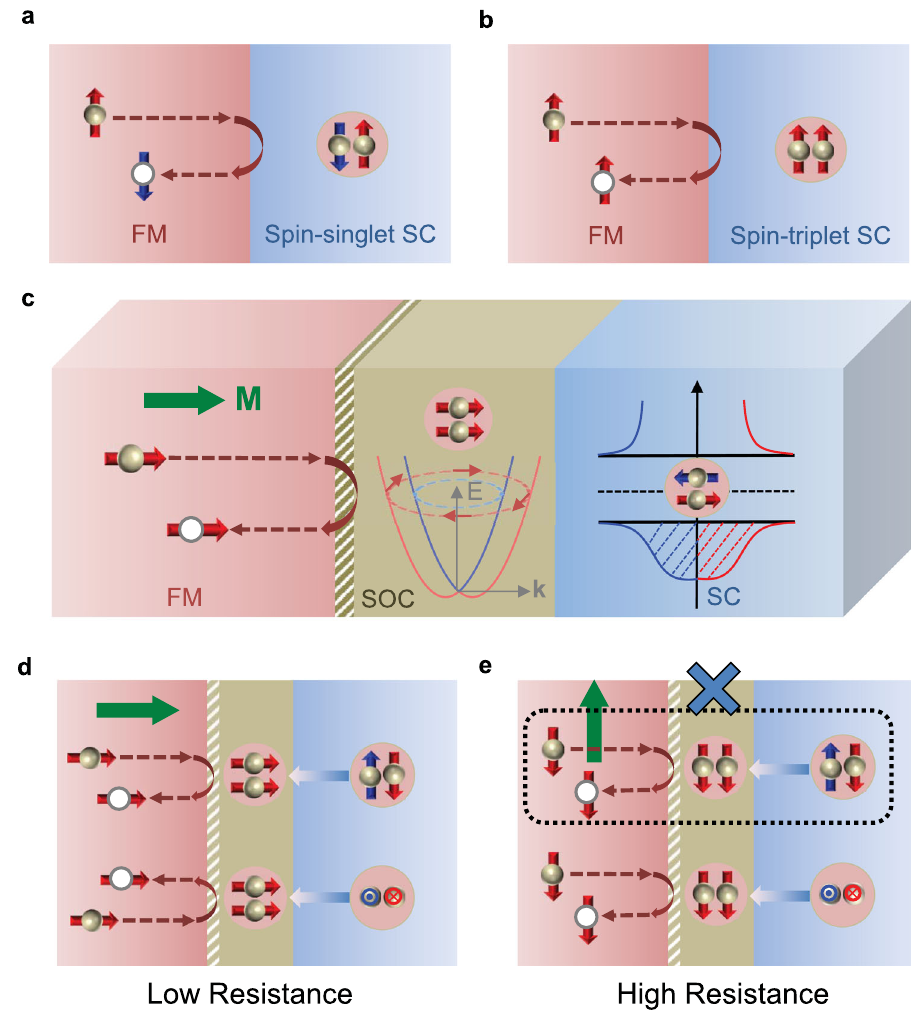
Fig. 1 Schematic of the spin-triplet Andreev re fl ection at FM/SC interface. a Conventional Andreev re fl ection at the FM/spin-singlet SC interface. b The spin-triplet Andreev re fl ection at the FM/spin-triplet SC interface. c Schematic of the spin-triplet Andreev re fl ection resulting from Rashba SOC at the interface between a FM and a conventional s -wave SC. The arrows in Rashba SOC band indicate spin-momentum locking and the red arrows represent the spin-polarization direction of equal-spin-triplet pairs. d , e Anisotropic spin-triplet Andreev re fl ection at the FM/SC interface and the low/high interfacial resistance states that depend on the FM magnetization direction, M (green arrow). Red arrows at the interface denote the spin direction of equal-spin- triplet pairs. For M along the interface the spin-triplet Andreev re fl ection can be